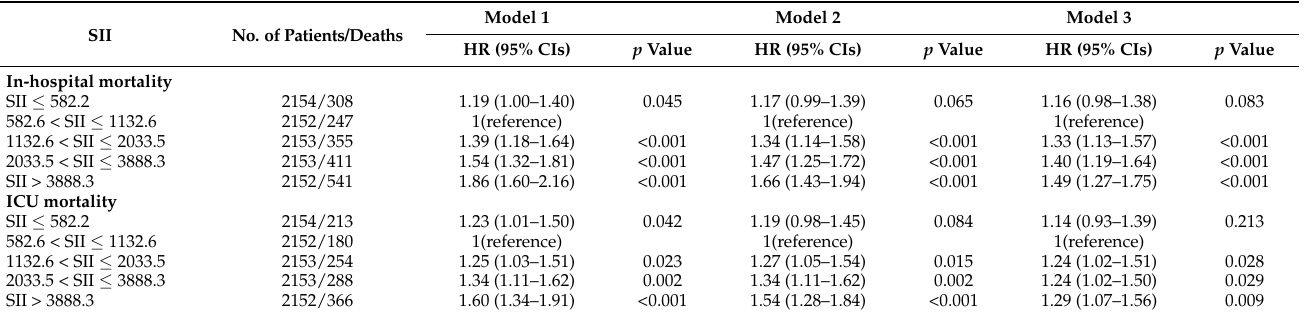
Figure 2. Relationship between the SII and the risk of all-cause mortality. ( A ) Relationship between the SII and in-hospital mortality. ( B ) Relationship between the SII and the ICU mortality. Shaded areas around the curves depict 95% confidence interval. SII, Systemic-immune inflammation index; ICU, Intensive care unit. Table 2. The multivariate Cox regression analysis for exploring the association of SII with all-cause mortality among critically ill patients with